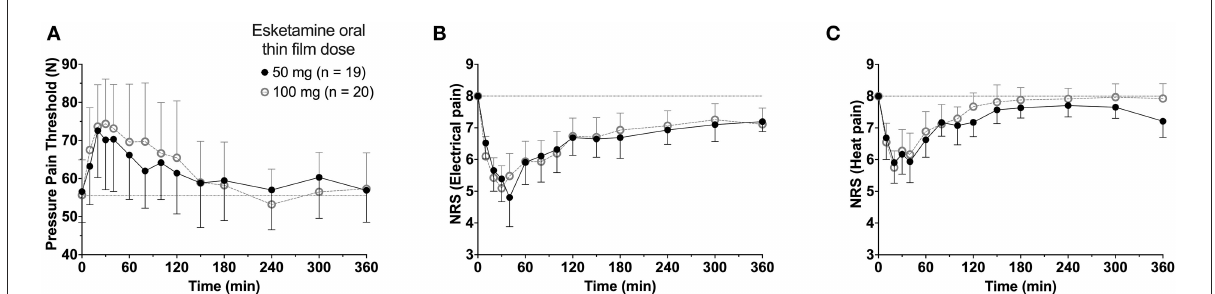
FIGURE2 Antinociceptive data. The effects of the 50mg and 100mg S- ketamine oral thin film on pain responses for the three pain assays, pressure pain threshold (A) , electrical pain numerical rating scale (B) , and heat pain numerical rating scale (C) . Date are mean ± 95% confidence interval.